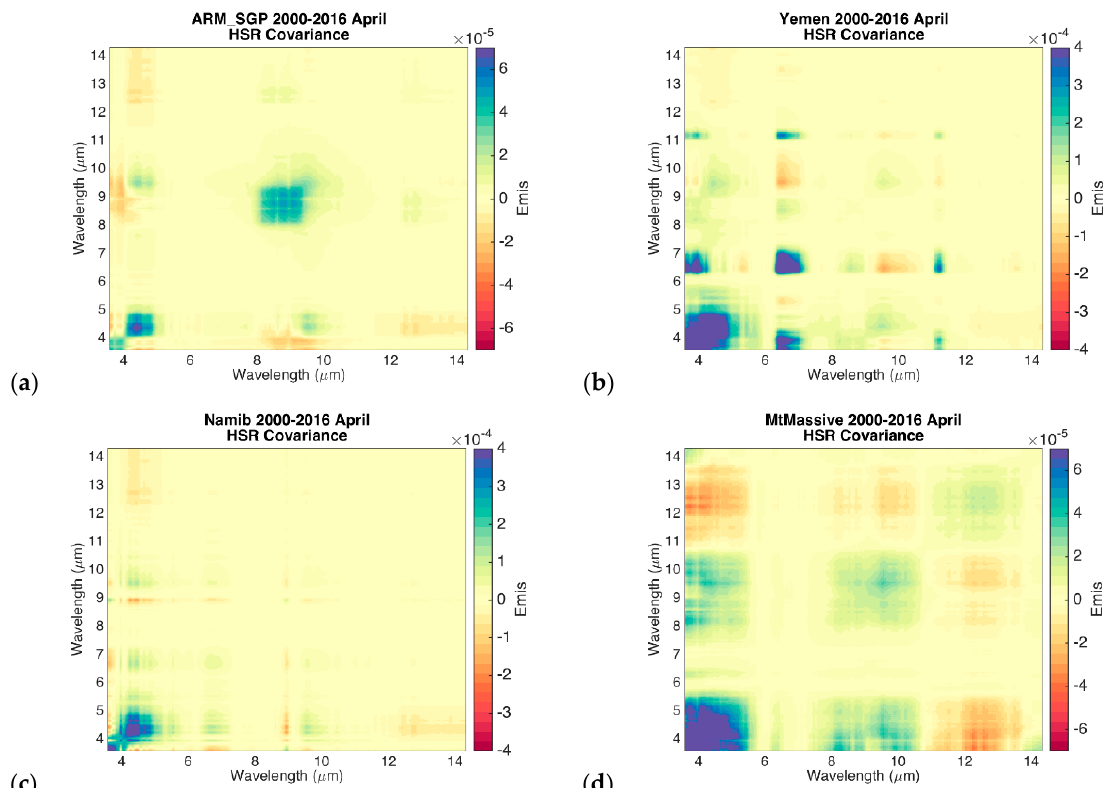
Figure 3. April 2000–2016 CAMEL HSR emissivity covariance for the ( a ) ARM SGP, ( b ) Yemen, ( c ) Namib, and ( d ) Rocky Mountain, Mt. Massive case site. Corresponding HSR emissivities are shown in Figure 2. Note the scale change for each site.